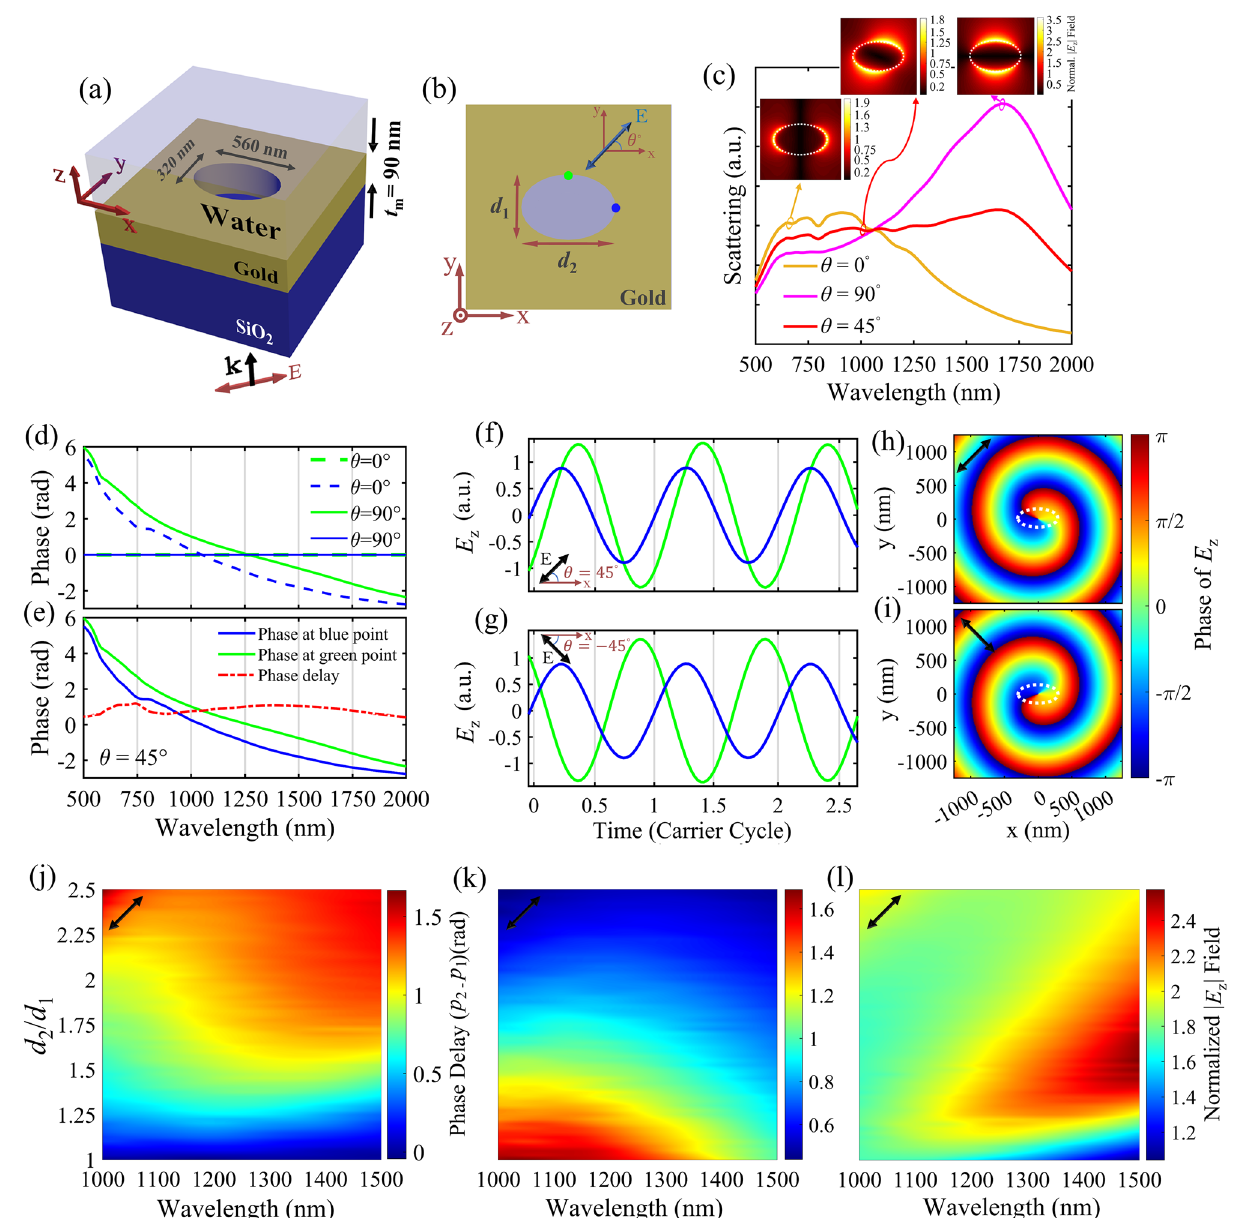
Figure 1. ( a ) Three-dimensional and ( b ) top-view (x–y plane) schematic diagrams of an elliptical hole embedded in a gold layer deposited on the glass substrate. d 1 and d 2 are the minor axis and the major axis of the elliptical hole, respectively. ( c ) The scattering spectrum of a single elliptical hole measured in different θ values of 0°, 90° and 45°. Dimensions of the hole are d 1 = 320 nm and d 2 = 560 nm. The insets show corresponding normalized spatial distribution of the E z components. ( d , e ) calculated phase of E z field under θ = 0°, 90° and 45° at two observation points marked by blue and green dots in ( b ). ( f , g ) The relative amplitude and phase relationships between green and blue points for θ = 45° and − 45°, respectively, for λ 0 = 1047 nm. ( h , i ) the phase distribution of E z field in 2π range around a single elliptical hole for θ = 45° and − 45°, respectively. White dashed lines illustrate the elliptical hole boundaries. ( j ) Calculated phase delay of E z between blue and green points as a function of d 2 / d 1 and wavelength, for θ = 45°. Here, P 2 and P 1 represent phase values at green and blue points. ( k , l ) Calculated instantaneous normalized E z field, for θ = 45° as a function of d 2 / d 1 and wavelength, at blue and green points respectively. Black arrows in parts ( f – l ) indicate polarization orientations. All simulation results are probed at 10 nm above the gold layer, in water